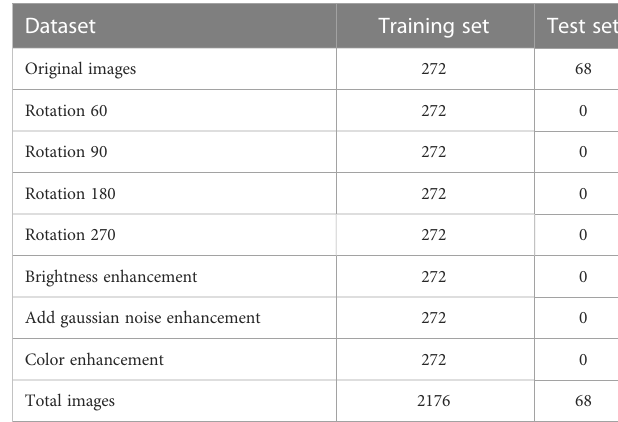
TABLE 1 Sample distribution.